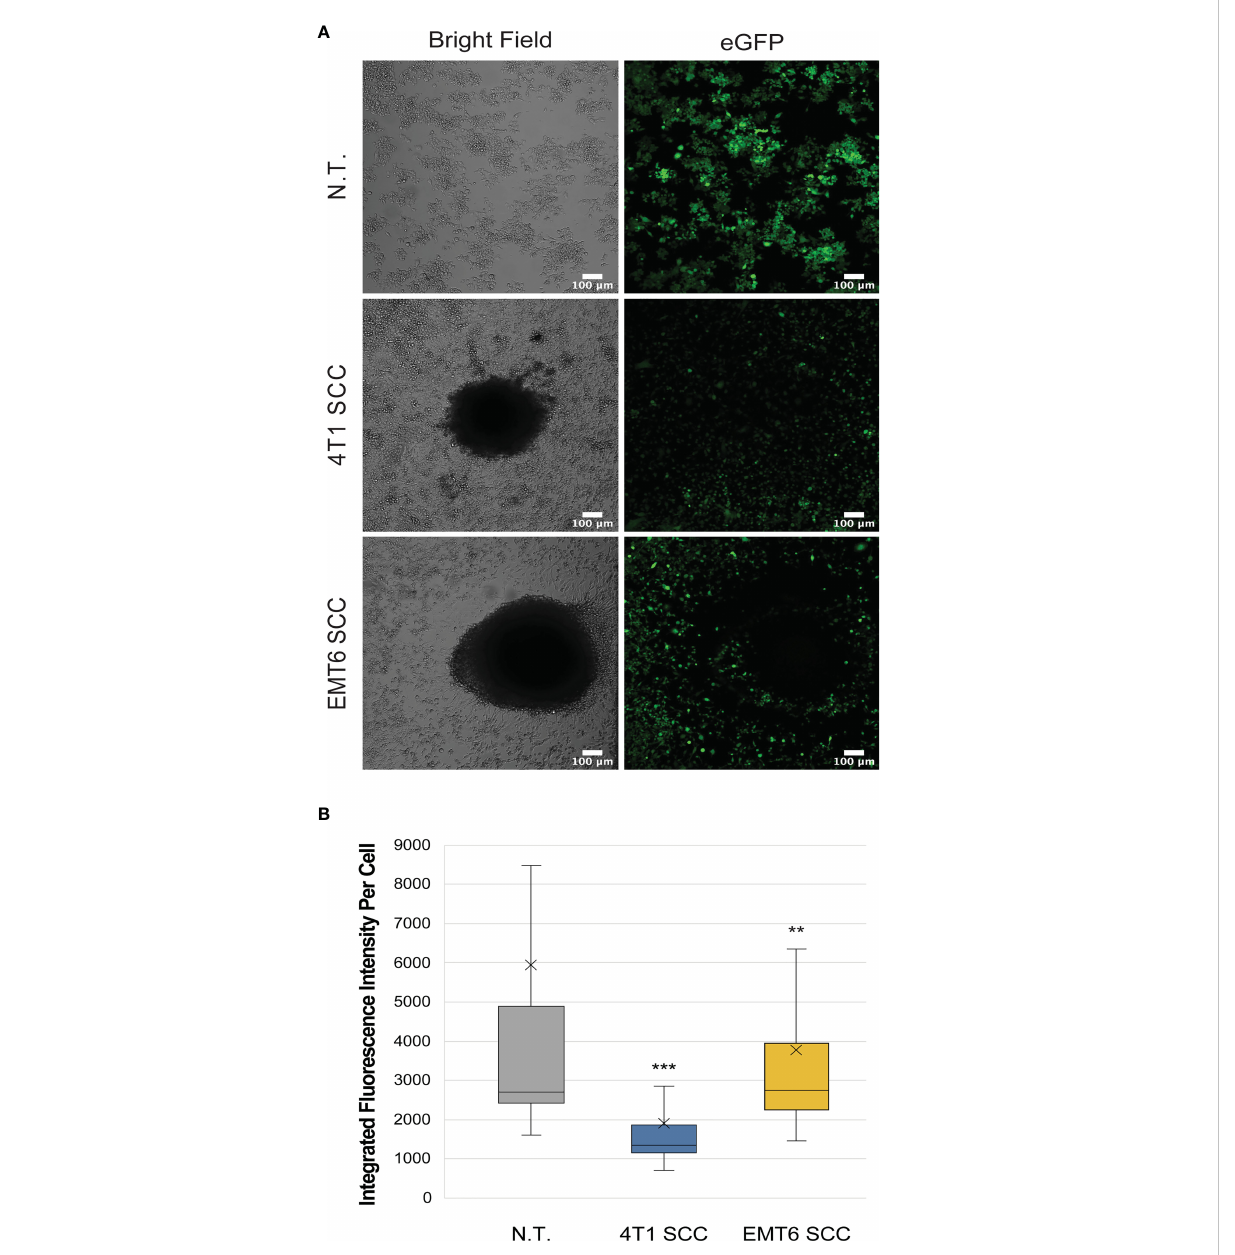
FIGURE 3 Macrophage reporter responses in three-dimensional tumor models. (A) Representative confocal images of RAW: iNos -eGFP macrophages (top row) after 48 h exposure to 4T1 (middle row) or EMT6 (bottom row) spheroids. In the latter two rows, the black area in the respective images is the spheroid itself. The 4T1 spheroid co-culture (SCC) results in the lowest levels of iNos-mediated fl uorescence. eGFP = enhanced green fl uorescent protein. Scale bars represent 100 µm. Additional spheroids are shown in Figure S4. (B) Per-cell fl uorescence quanti fi cation of confocal images from (A) . The “ x ” in the box represents the mean; the bottom and top lines of the box represent the median of the bottom half (1st quartile) and median of the top half (3rd quartile), respectively; the line in the middle of the box represents the median; the whiskers extend from the ends of the box to the minimum value and maximum value. Student T-test was used for statistical analysis of 4T1 SCC (n = 406) and EMT6 SCC (n = 337) versus N.T. (n = 2,111); (p<0.01 = **, p<0.001 = ***). N.T.= non-treated